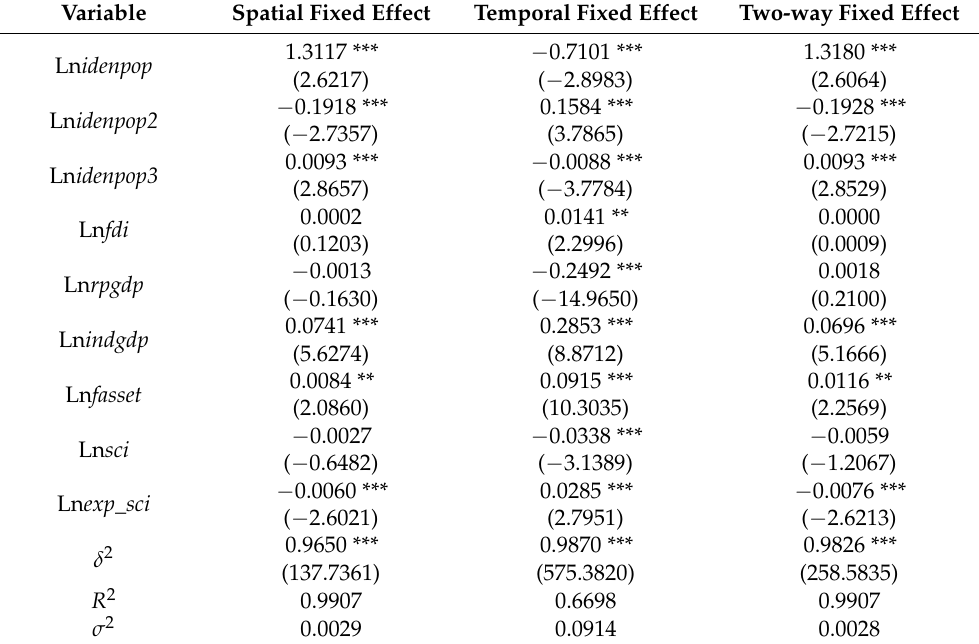
Table 3. Spatial Lag Model Regression Results Under Three Fixed Effects. The first column is the variable name, and the last three rows represent the estimation results of the three spatial lag models under the variable space fixed effect, time fixed effect, and space and time double fixed